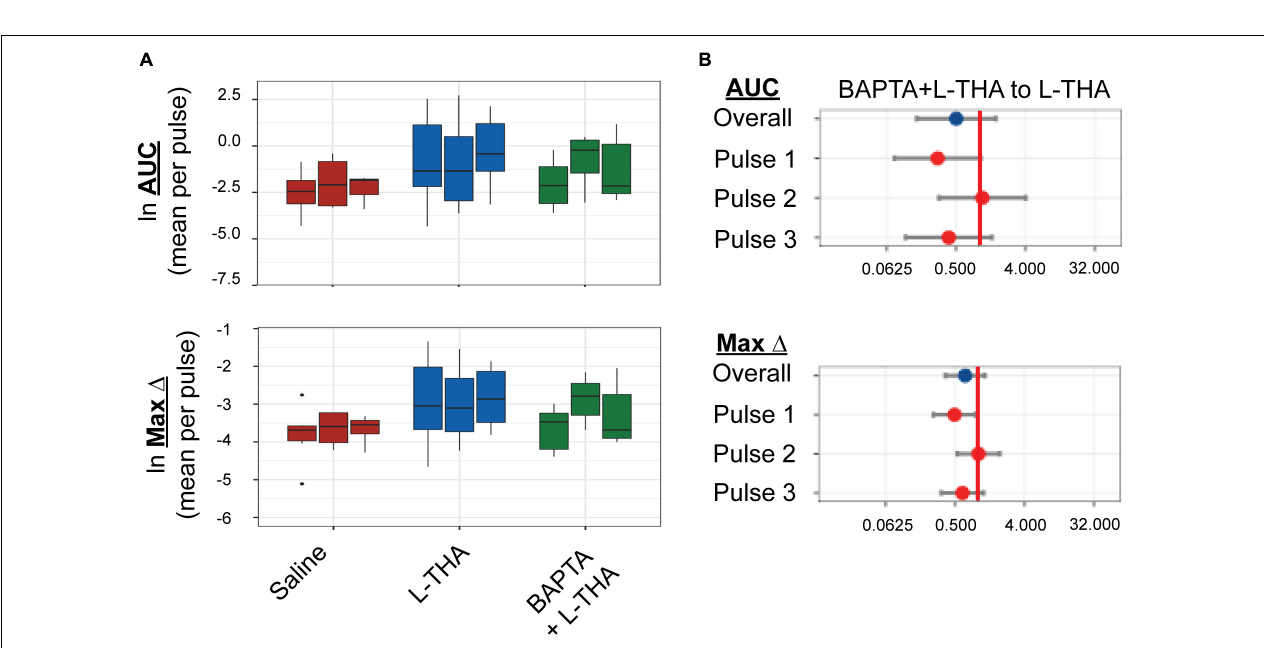
FIGURE 6 | Effects of saline, L-THA, or L-THA with BAPTA pretreatment on arteriole diameter. Saline, L-THA (100 µ M), or L-THA after pre-treatment with BAPTA (see methods) were picospritzed near cortical arterioles. (A) Data are presented as boxplots. (B) Forest plots are also included to show the mean differences expressed as ratios of the effect of BAPTA with L-THA over that observed with L-THA. The redline is at 1 and represents no difference. The data for saline and L-THA are described in Figure 4 legend, the data for BAPTA with L-THA are from 6 animals (2 males, 4 females).